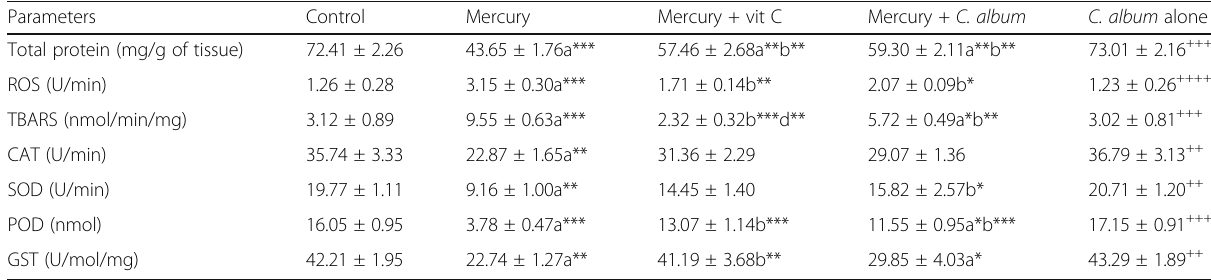
Table 3 Protective effect of C. album extract against HgCl 2 -induced alteration in tissue protein content, oxidative stress markers,